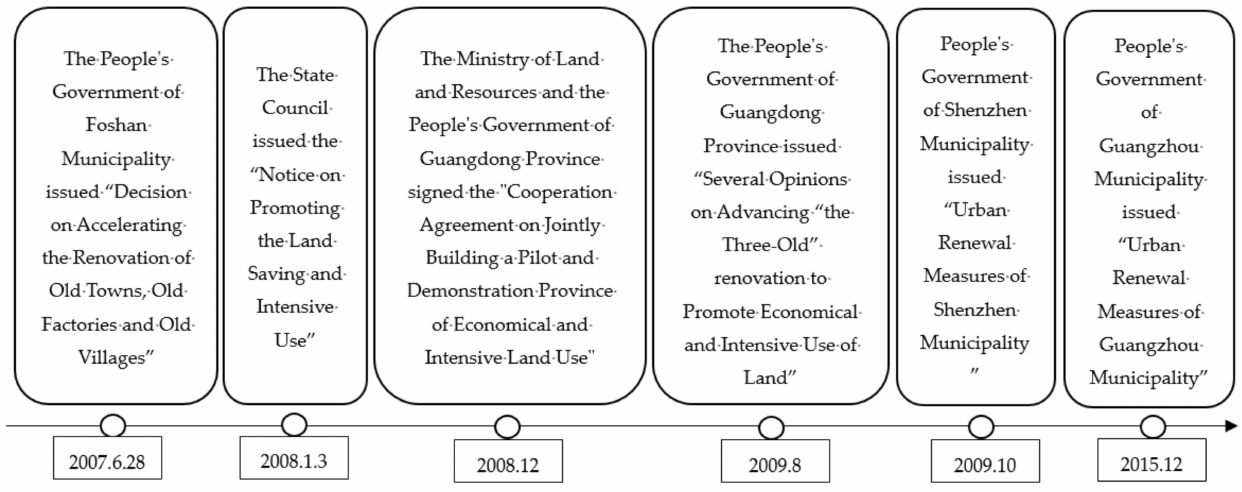
Figure 1. Historical evolution of urban renewal policy in Guangdong